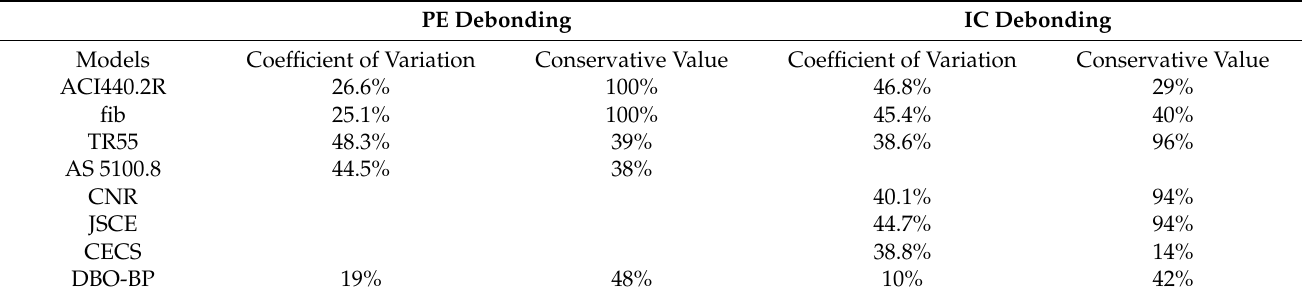
Table 3. Model Evaluation.